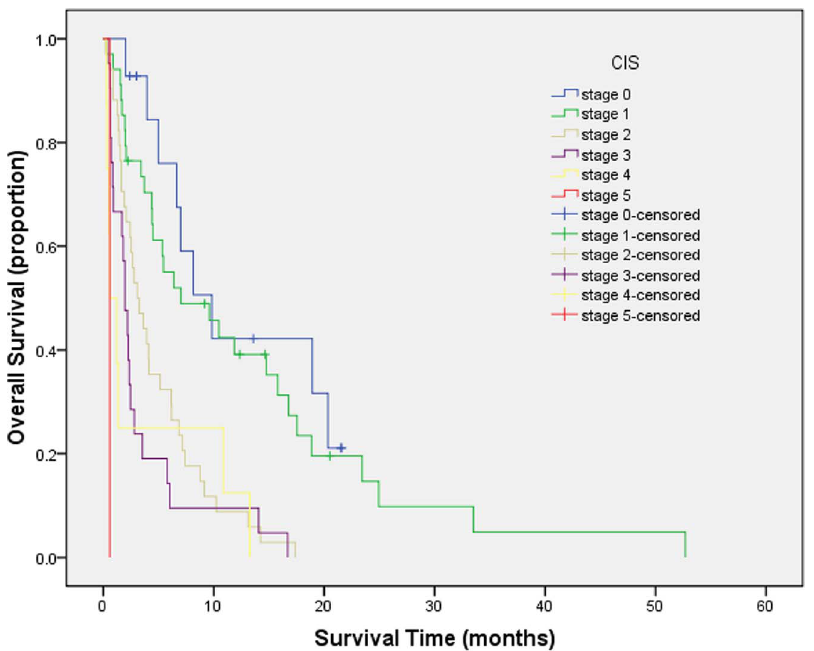
Figure 7. Survival curves for patients with unresectable hepatocellular carcinoma who stratified according to the China Integrated Score. Score 0 versus 1, P=.366; score 1 versus 2, P=.004; score 2 versus 3, P=.056; score 3 versus 4, P=.093; score 4 versus 5, P=.853. The difference was significant only between scores of 1 and 2.